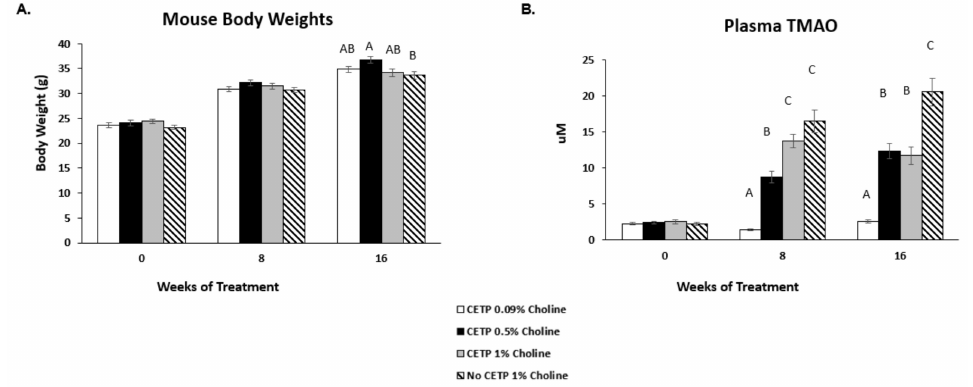
Figure 1. Mouse body weights and plasma TMAO levels in vivo. Apoe − / − mice were transfected with cholesterol ester transfer protein (CETP)-AAV at 7–8 weeks of age prior to choline supplementation. Animals were assigned to the indicated treatment groups at 9–10 weeks of age and fed diets for 16 weeks. ( A ) Mouse body weights for all treatments were evaluated to monitor overall health. ( B ) Plasma levels of trimethylamine N-oxide (TMAO) were measured at baseline, as well as 8 and 16 weeks after treatment. Data are presented as mean ± SEM ( n = 10–12 mice/group). One-factor